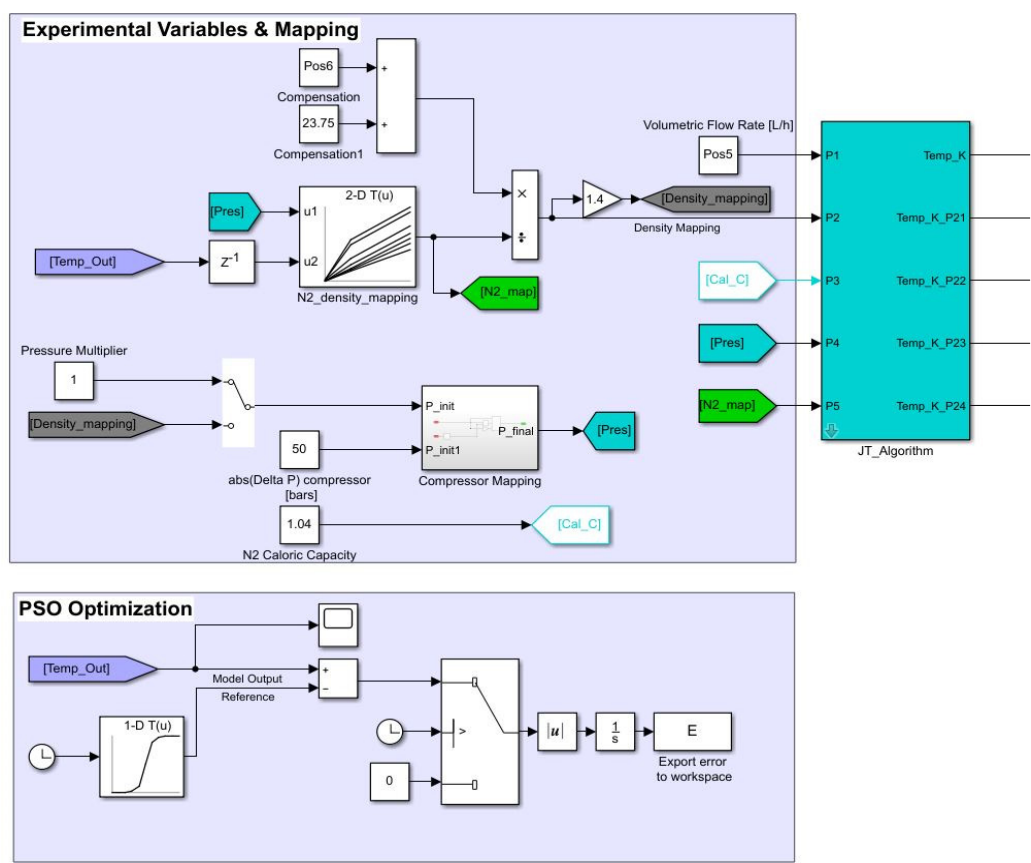
Figure 15. Density mapping and decompression behavior. All outputs were filtered using first order filters for further smoothing of characteristics, having the first filtered output, “Temp_K”, corresponding to the “Temp_Out” tag.